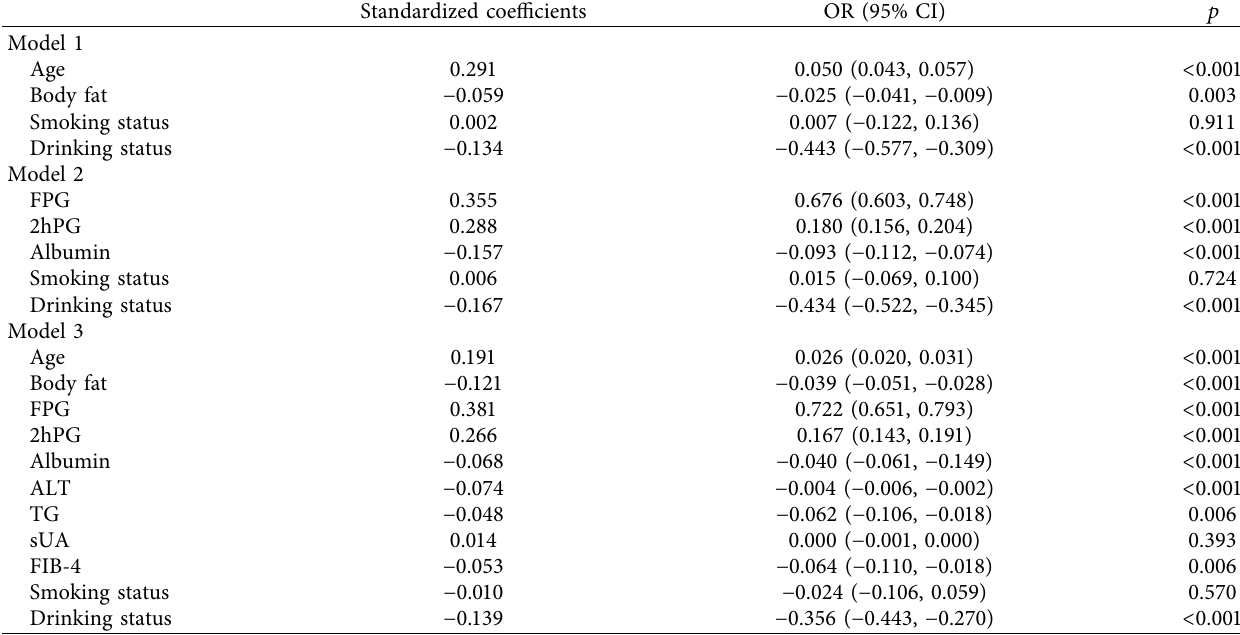
Table 4: Linear regression to determine the variables associated with GA.